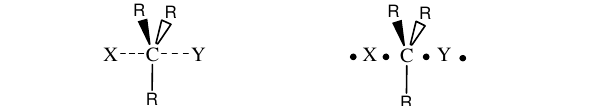
Figure 8. Classic presentation (left) and new suggested structure (right) of transition state in S 2 N